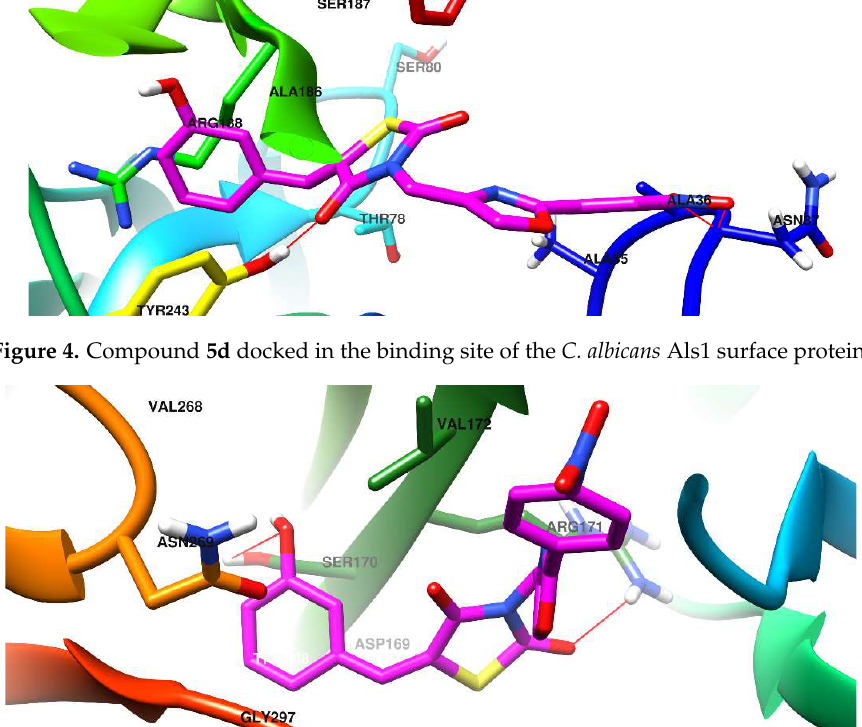
Molecules 2018 , 23 , x 11 of 24